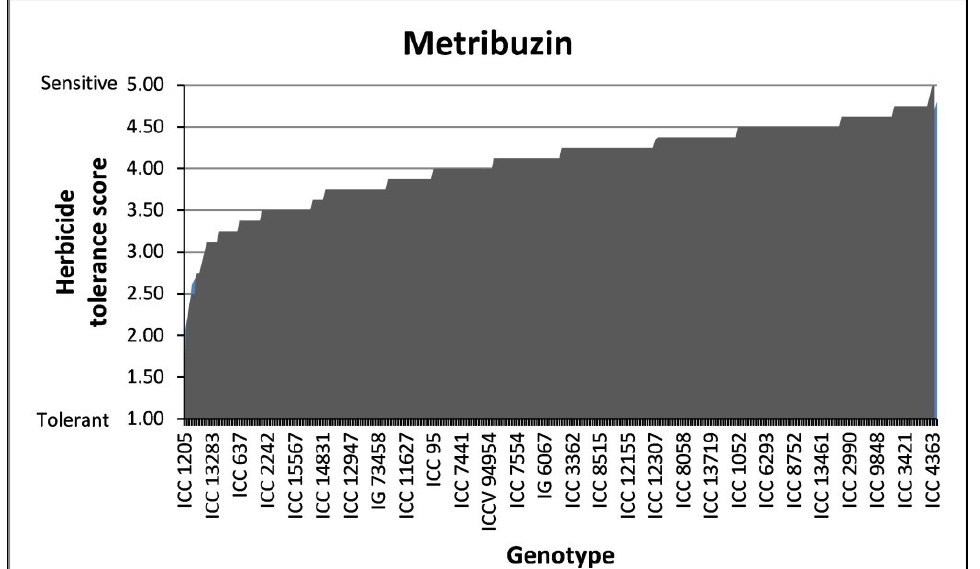
Figure 1. Range of variation in chickpea genotypes studied for tolerance to herbicide